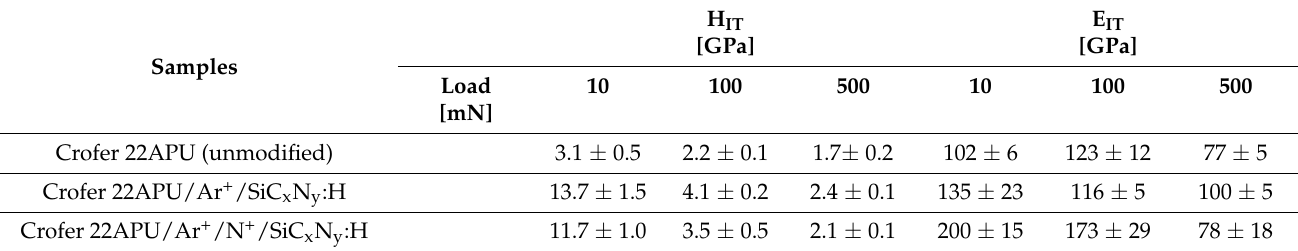
Table 4. Hardness (H IT ) and Young’s modulus (E IT ) for different indenter loads applied to the unmodified Crofer 22APU steel, Crofer 22APU steel with SiC x N y :H layer, and N + ion modified Crofer 22APU steel with SiC x N y :H layer